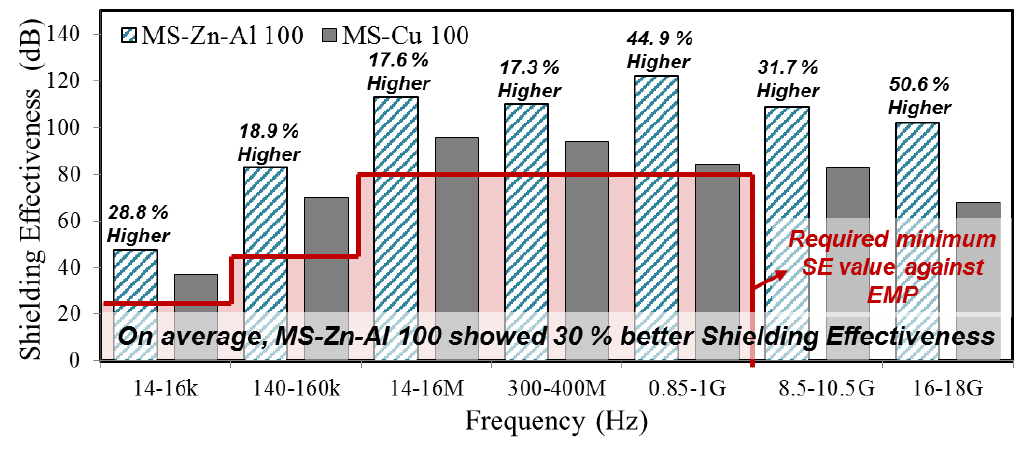
Figure 6. SE test result between MS-Zn-Al 100 and MS-Cu 100.